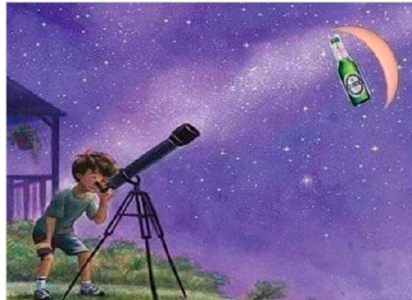
Figure 5. © unknown.